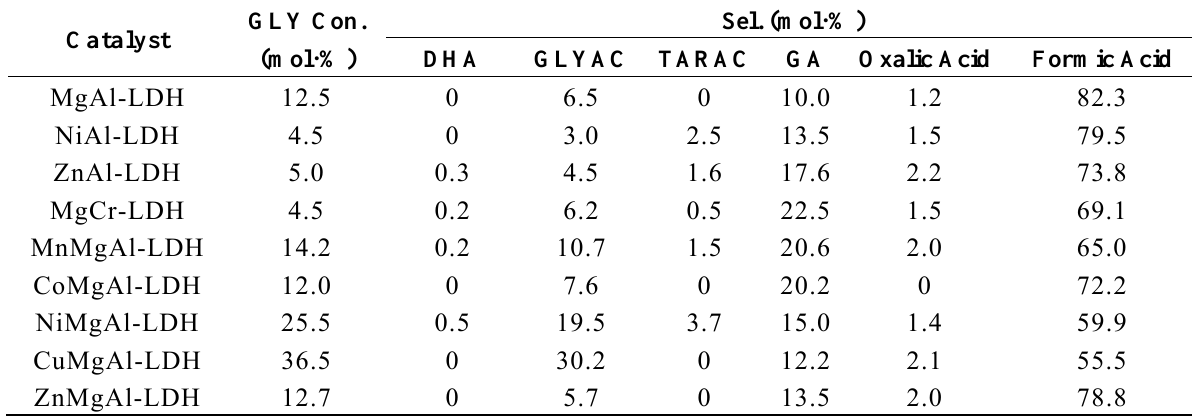
Table 2. Catalytic performance of LDH samples in GLY oxidation a